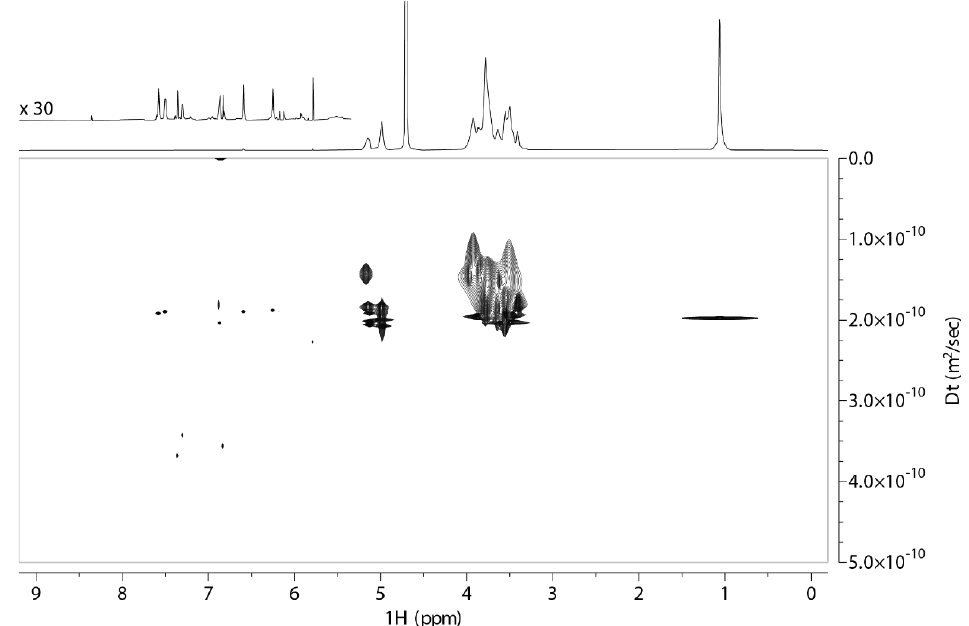
Figure 4. DOSY spectrum obtained of 2,6Me- β -CD-QUE (1:1) at 25 °C in D 2 O recorded on an 800 MHz NMR spectrometer. The corresponding 1 H NMR spectrum is shown above, with an expansion of the aromatic region at 30-fold increased intensity. The recorded 2D DOSY experiment of the complex of QUE with 2,6Me- β -CD formation 1:1. The spectrum was obtained at 25 °C in D 2 O.